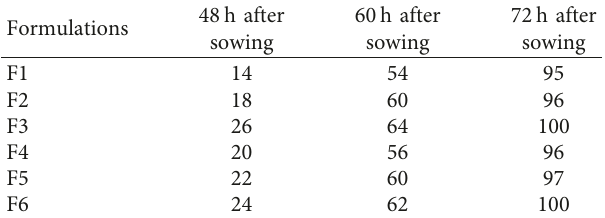
Table 1: Nutrientformulations for presowingsoybeanseed treatment. N Formulations